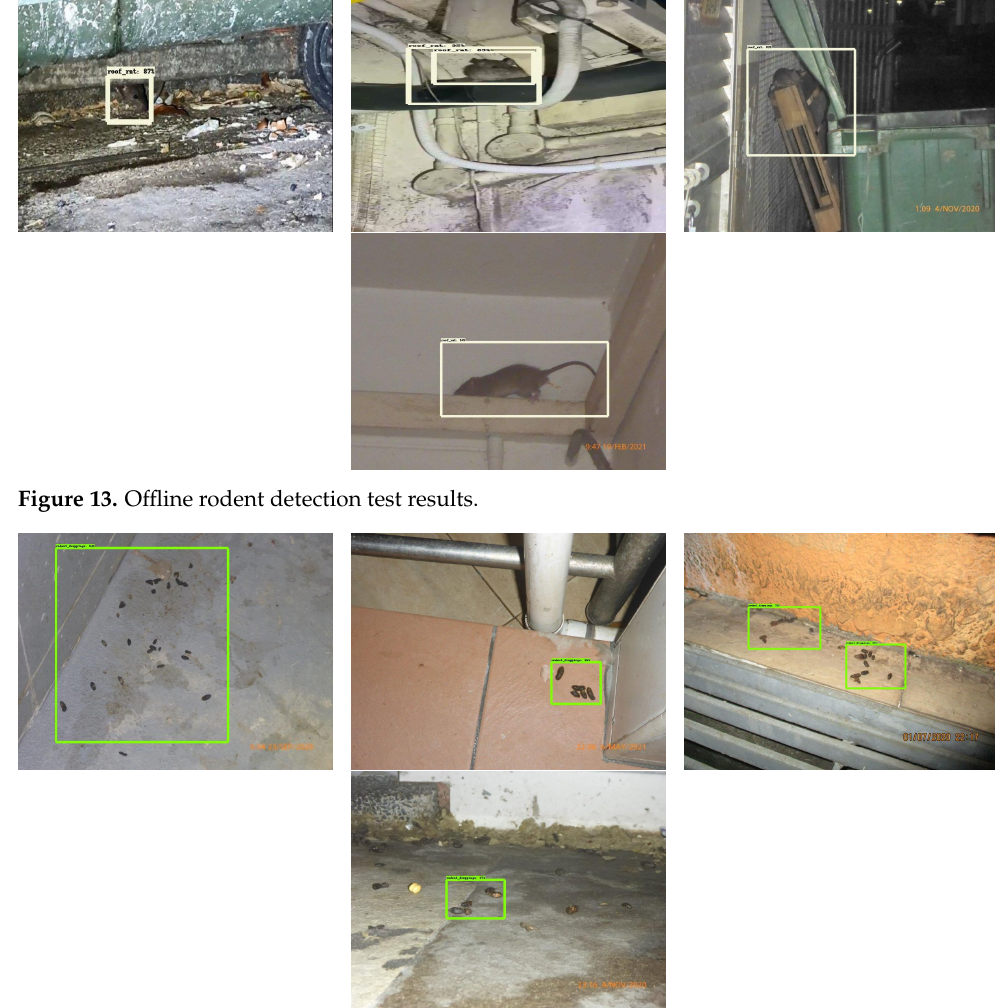
Figure 14. Rodent dropping detection results.